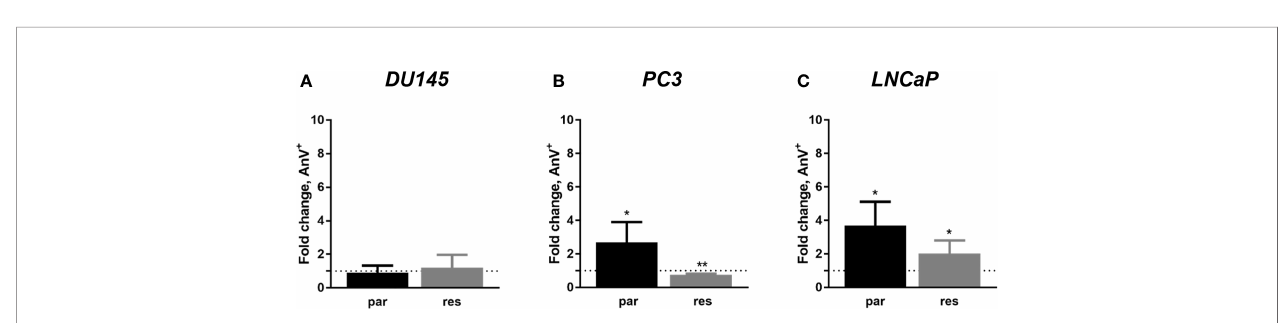
FIGURE 5 | Apoptosis induction: parental (par) and DX-resistant (res) DU145 (A) , PC3 (B) , and LNCaP (C) cells treated for 48 h with ART [37.5 µM]. The analysis was performed by Annexin V (AnV+)/PI detection (in fold change). Untreated cells served as controls (dotted line, set to 1). Error bars indicate standard deviation (SD). Signi fi cant difference to untreated control: *p ≤ .05, **p ≤ .01. n =